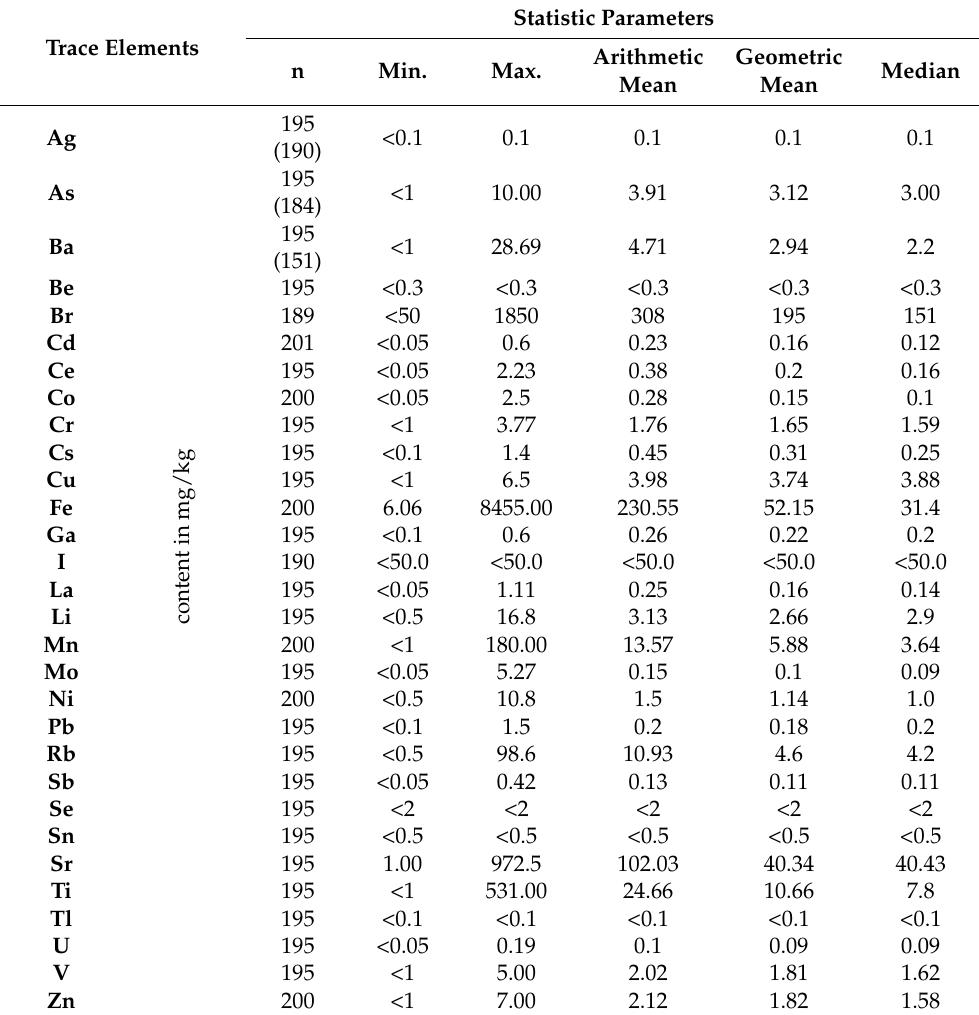
Table 7. Statistic parameters of trace element content in the potash-bearing deposits of the PZ3 cyclothem in